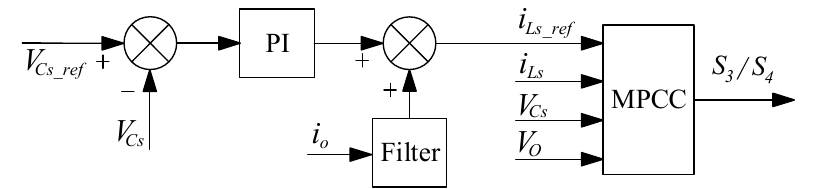
Figure 6. Bidirectional buck/boost converter based on MPCC.